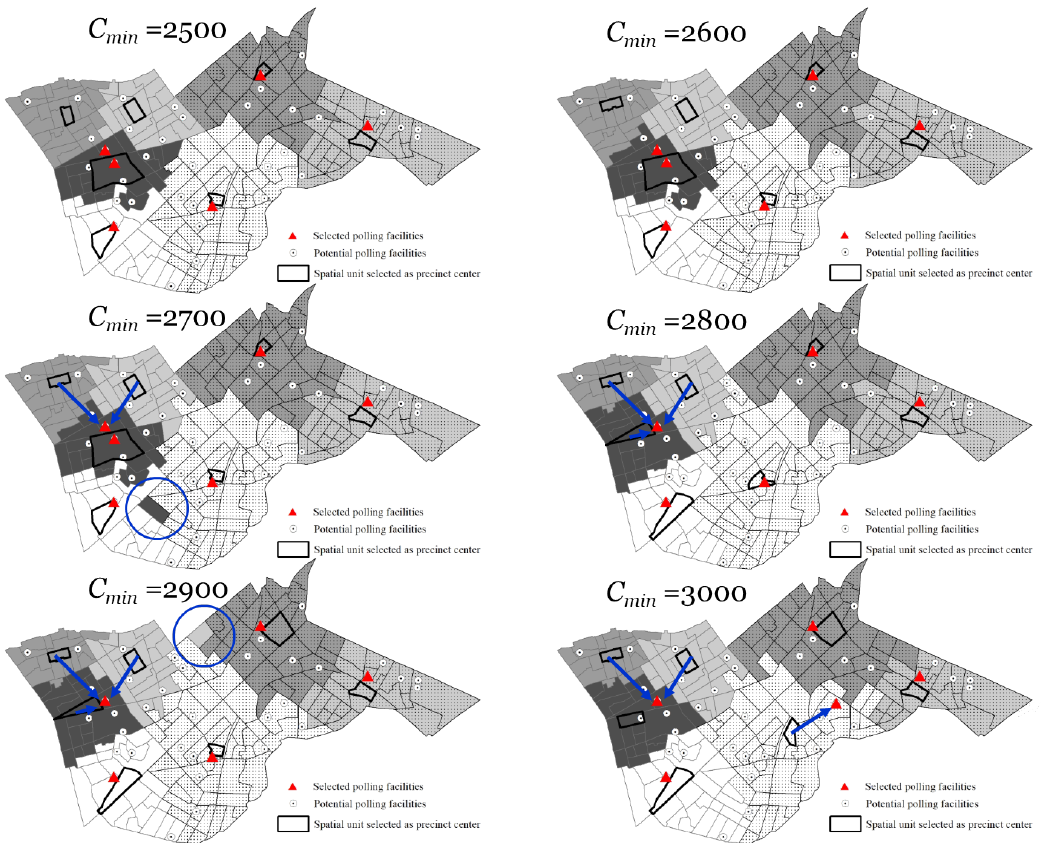
Figure 5. Delineated precincts and selected potential facilities when ß = 4.